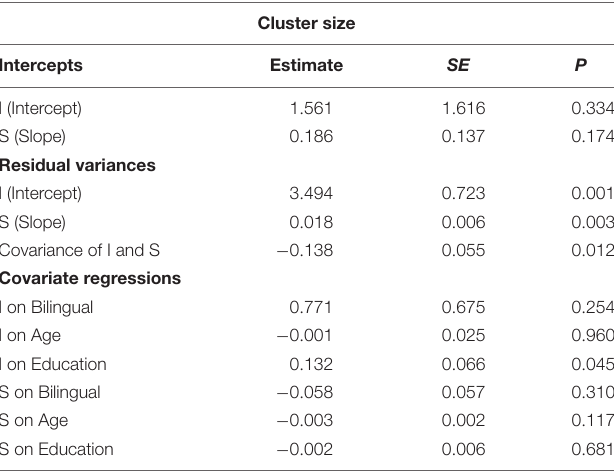
TABLE 7 | stimates from the Conditional LGM modeling cluster size using biligualism, age, and education as covarietes. Cluster